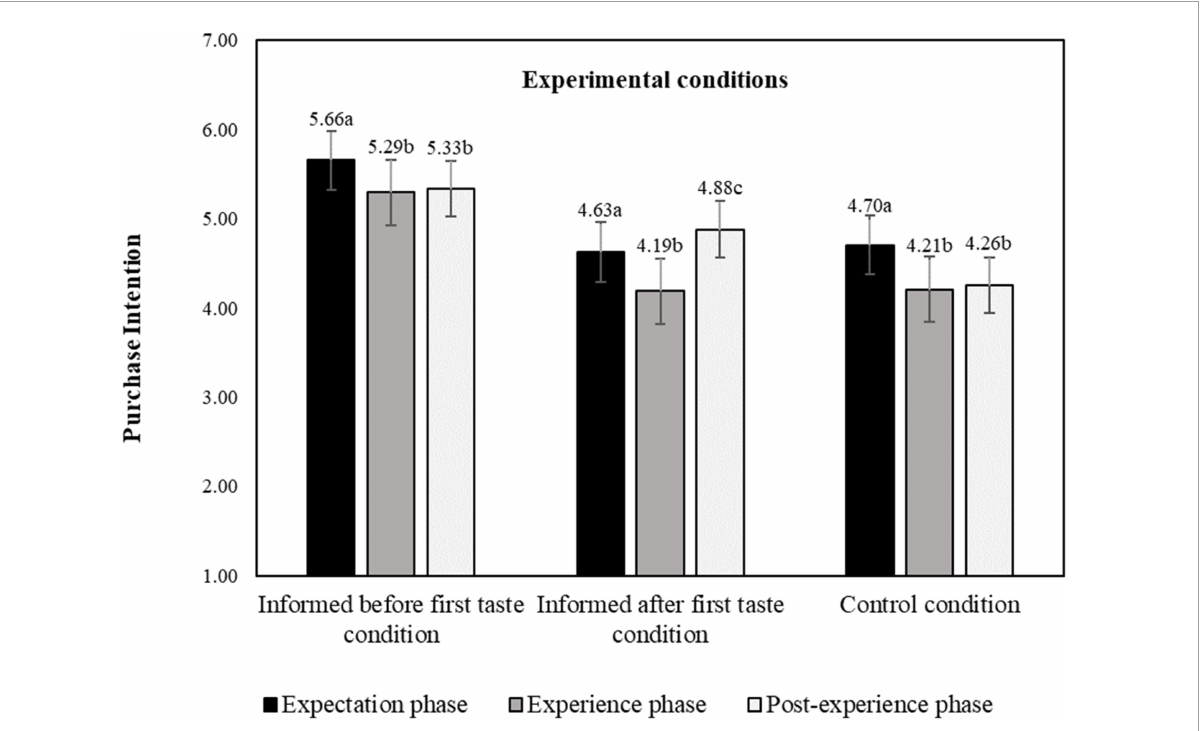
FIGURE6 Purchase intention by product evaluation phase and experimental condition estimated, marginal means; a–c: means with different letters are significantly different at p < 0.05 level; purchase intention measured on a 11-point probability scale. The bars display standard